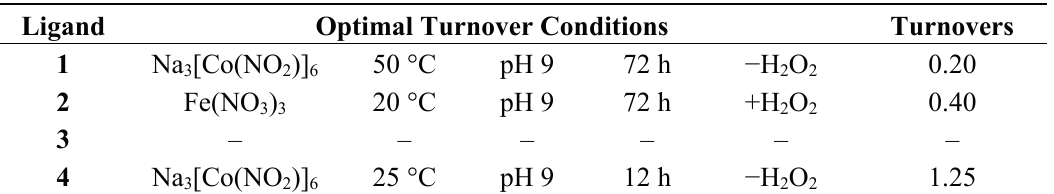
Table 2. Summary of optimal conditions for acetonitrile turnover with ligands 1 – 4